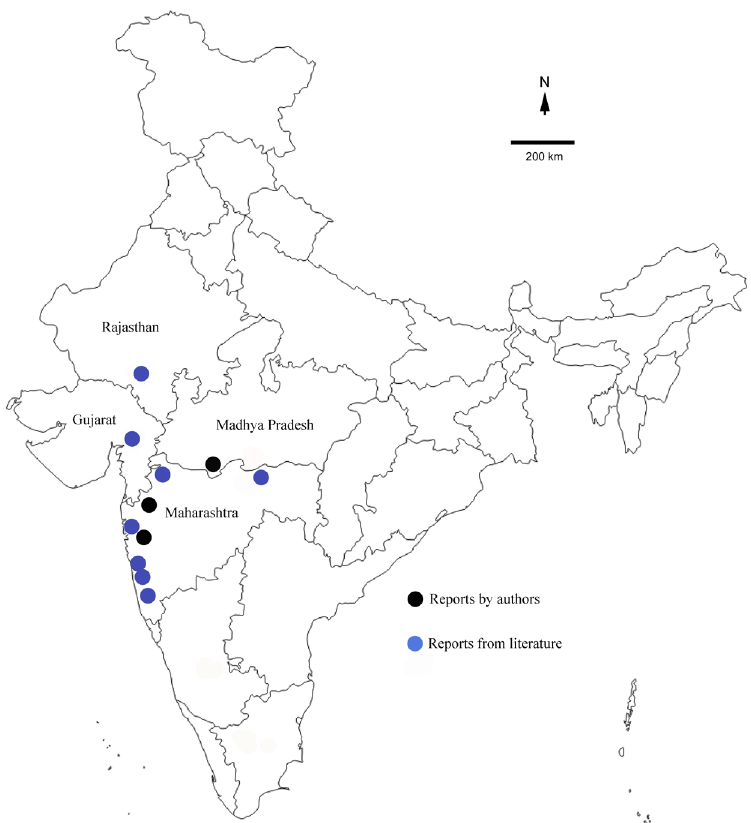
Figure 2. Distribution of Ceropegia